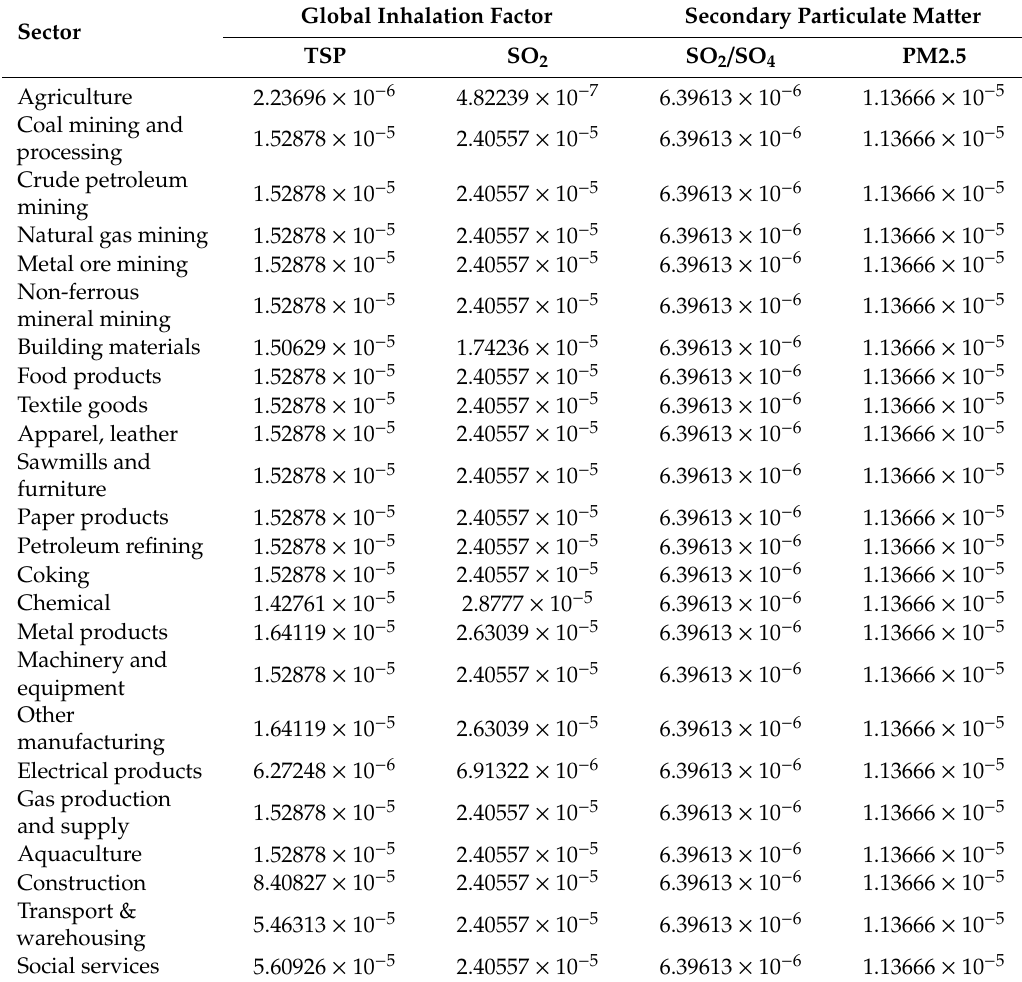
Table 2. Revised inhalation factors for primary and secondary